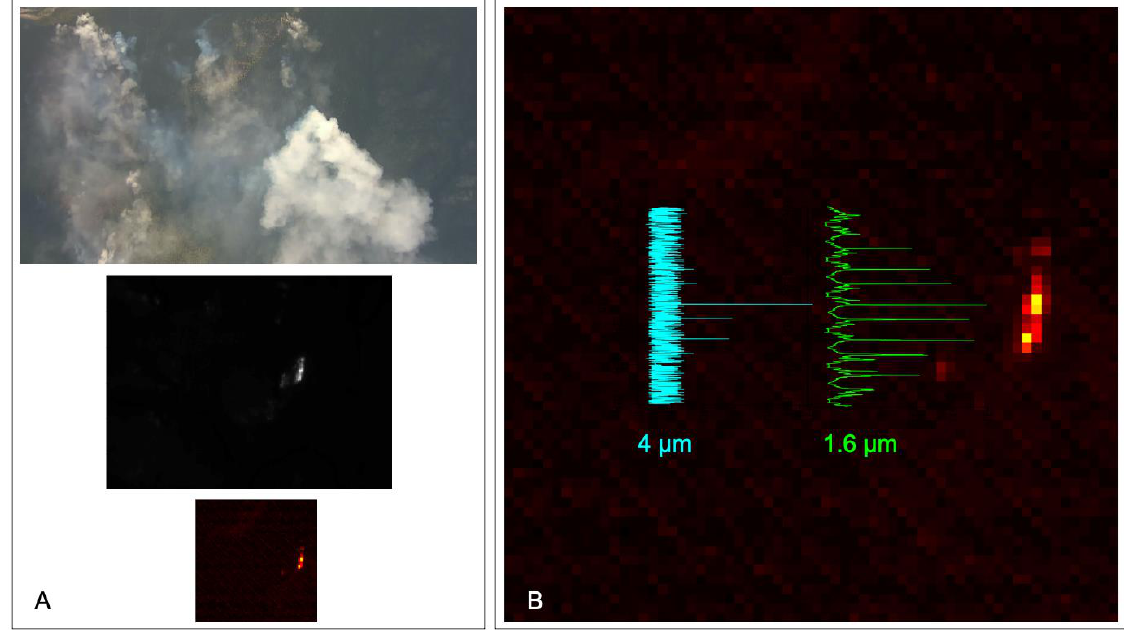
Figure 10. Images and scanner data of the Barren Hill wildfire in Idaho on 29 July 2019 observed from the NOAA-Met Twin Otter. ( A ) Images from the FLIR visible ( top ) and thermal ( middle ) cam- eras and SWIR camera ( bottom ). ( B ) The SWIR camera image is the same as shown in Panel A. Corresponding time series of the telescope scanner data (green = 1.6 µm, cyan = 4 µm) are also shown. The scanner time (vertical) axis is scaled to match the camera image.